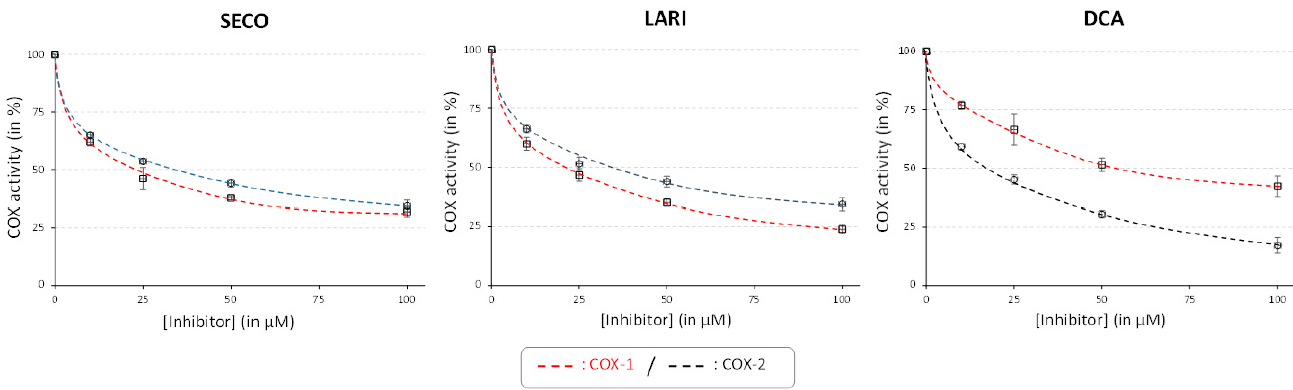
Figure 3. IC 50 curves for the inhibition COXs by the lignans (SECO and LARI) and neolignan (DCA) accumulated in L. grandiflorum in vitro cultures. Table 5. IC 50 (µM) values for COX inhibition by lignans and neolignan accumulated in L. grandiflorum in vitro cultures. COX-1 IC 50 COX-2 IC 50 Specificity Compound